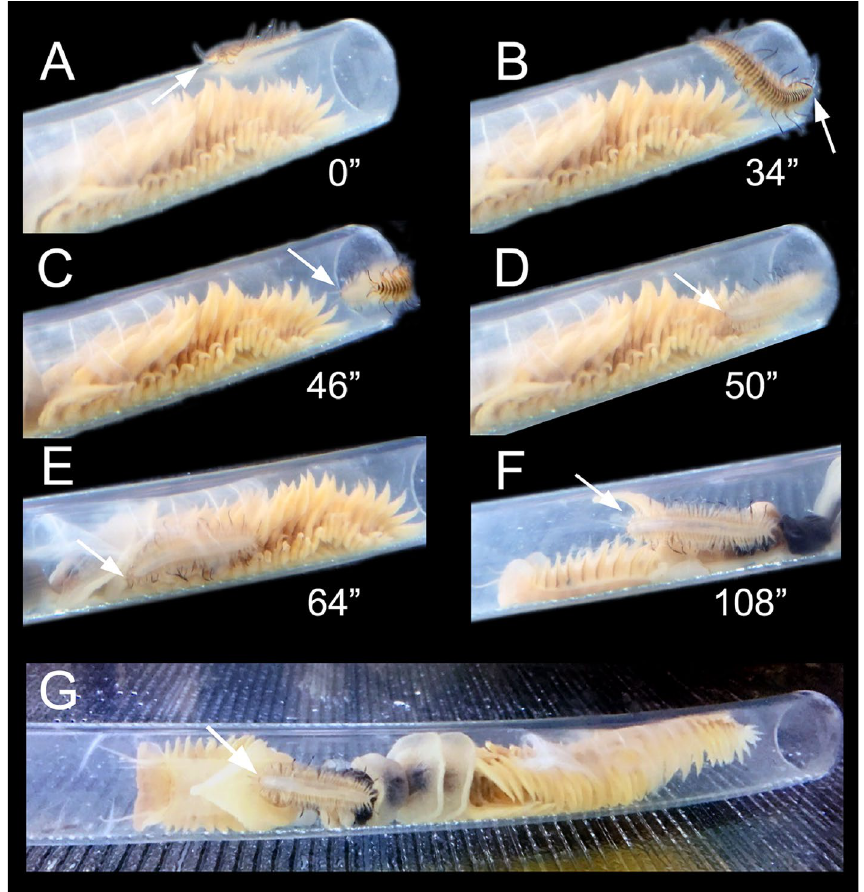
Figure 2. Ophthalmonoe pettiboneae host entering sequence, see Supplementary material S3. ( A ) Crawling outside the tube. ( B ) Approaching the exhalant siphon. ( C ) Entering through the exhalant siphon. ( D ) Already inside the tube. ( E ) Crawling inside the tube. ( F ) Reaching the typical position inside the tube. ( G ) Dorsal view of an example of the typical position inside the tube. White arrows indicate the symbiont head. Time course indicated in seconds.